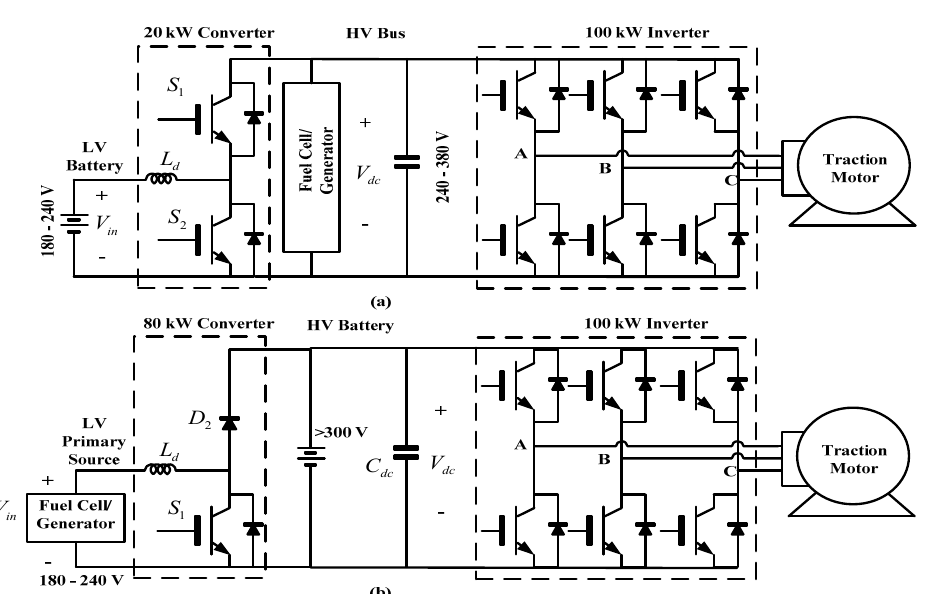
Figure 2. ( a ) High–voltage fuel cell supplemented with low–voltage battery (synchronous boost converter) and ( b ) Low–voltage fuel cell supplemented with high–voltage battery (conventional boost converter) [7].